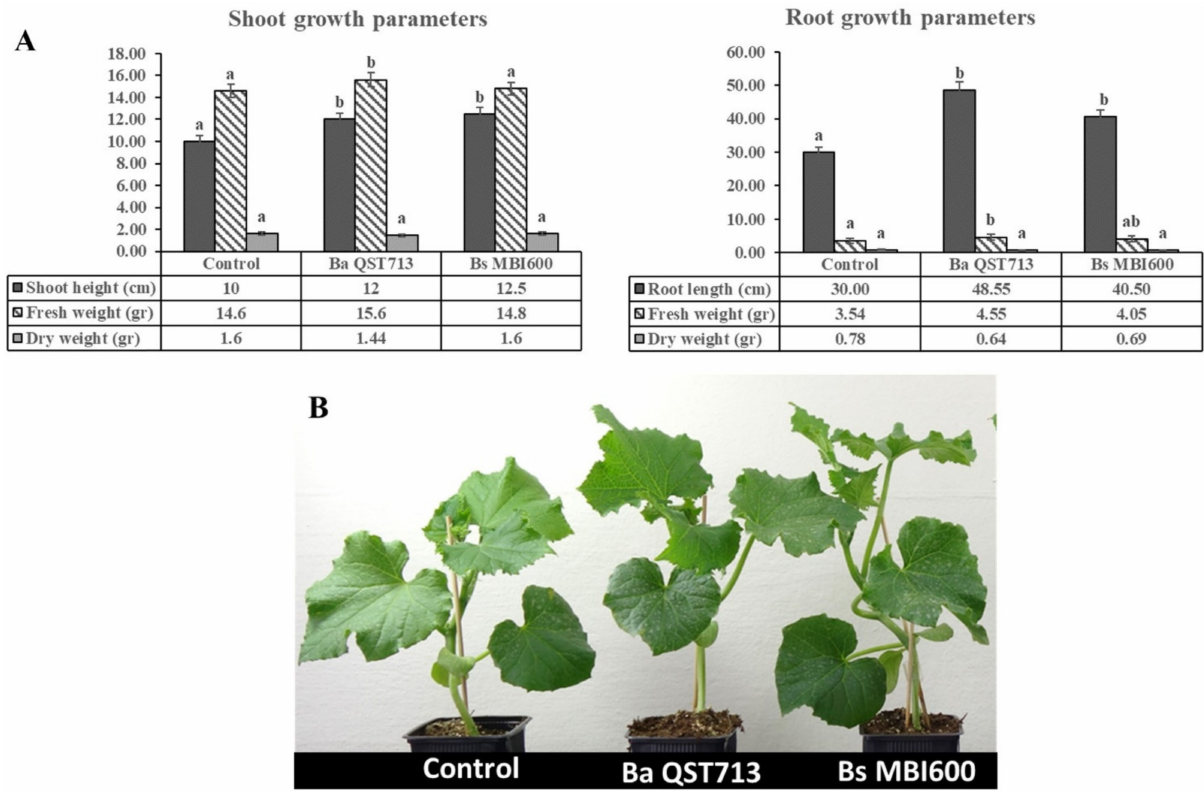
Figure 1. Effect of Bacillus subtilis MBI600 ( Bs MBI600) applications on cucumber plants. ( A ) Shoot and root growth parameters as compared to the growth of untreated control plants and Bacillus amyloliquefaciens QST713 ( Ba QST713)-treated plants. Different letters on the columns indicate significant differences according to Fisher‘s LSD test ( p < 0.05). Vertical lines indicate the standard error of the mean. (B ) Representative plants treated with Bs MBI600 and Ba QST713 as compared to untreated plants 35 days after